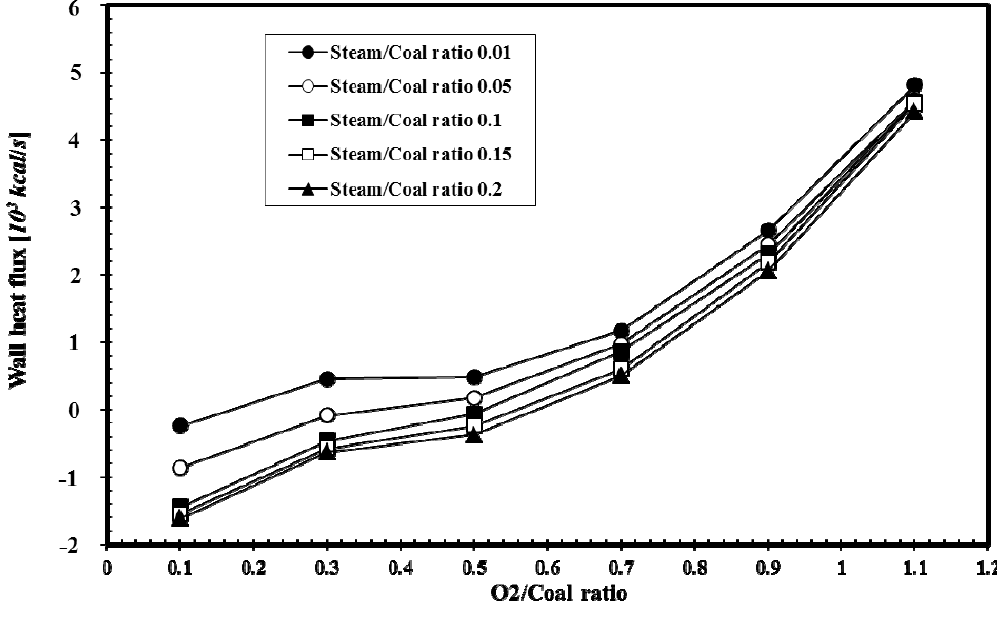
Figure 10. Wall heat flux of